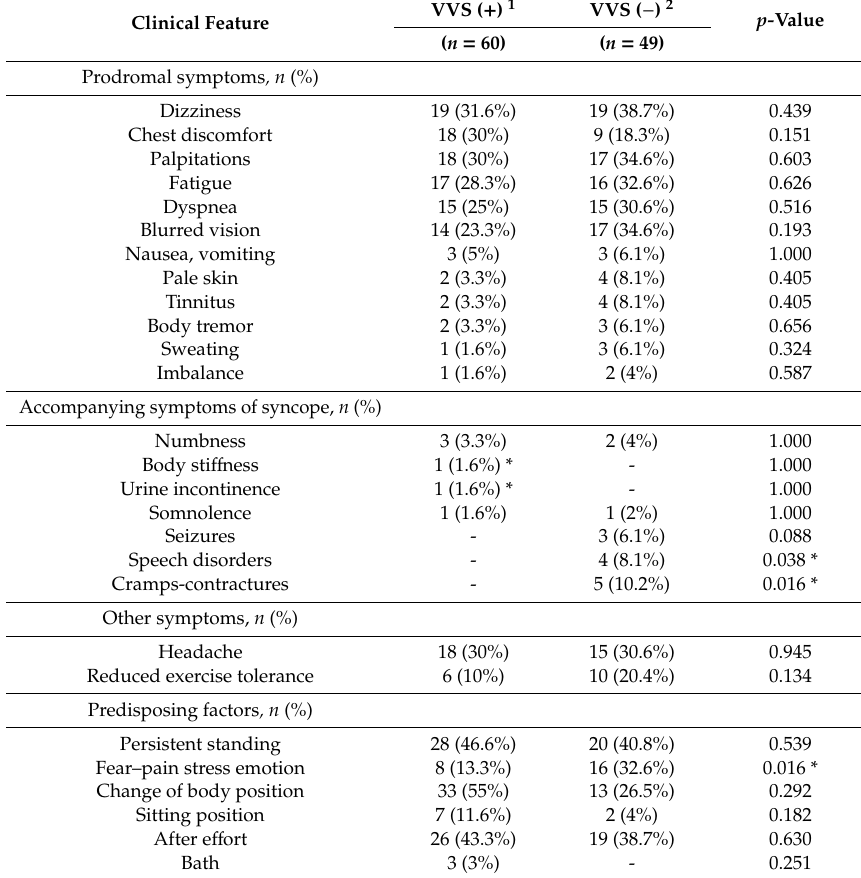
Table 3. Predictors of VVS in children and adolescents with positive and negative results of